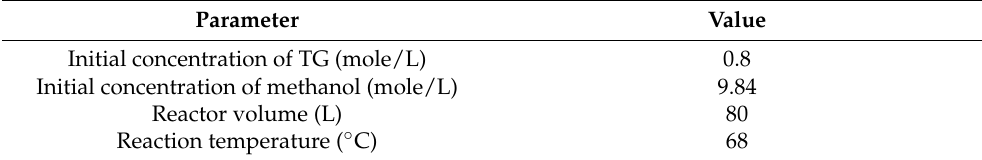
Table 8. The operating parameters of the membrane reactor system.